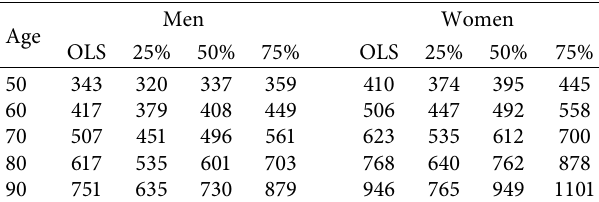
Table 7: Predicted times for selected ages using semilog model.